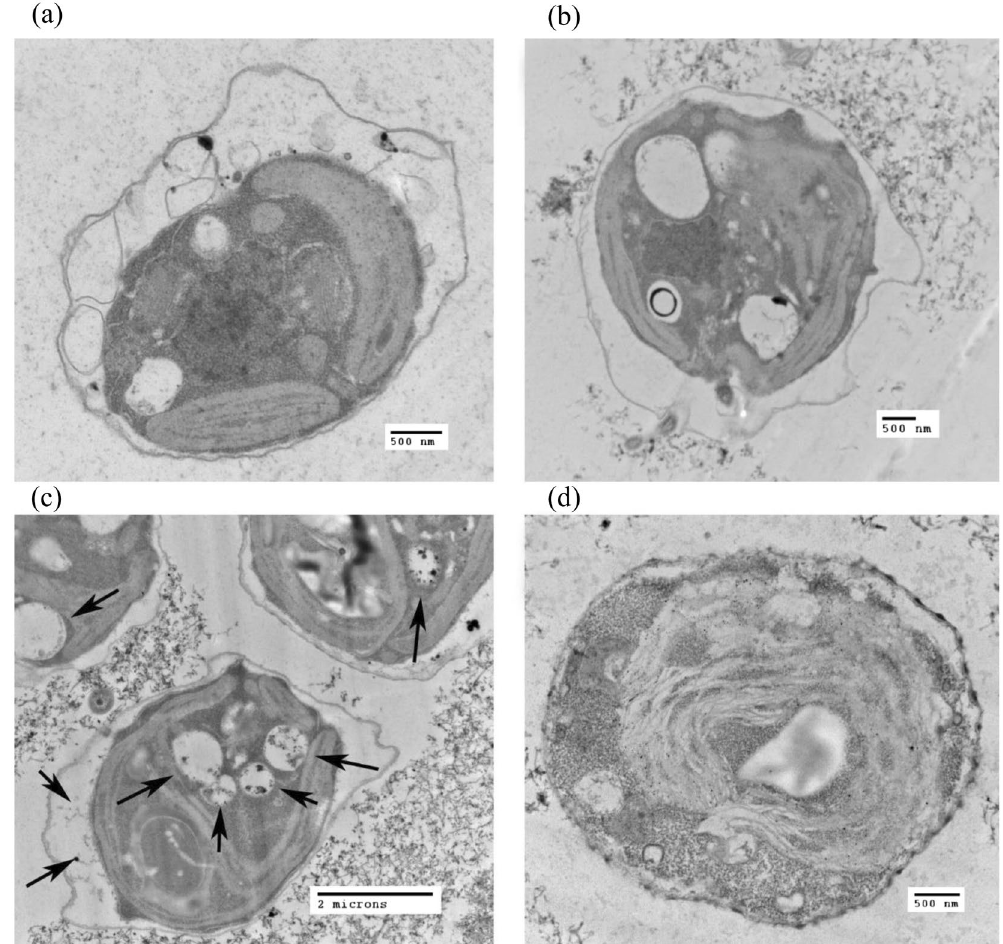
Figure 7. Representative TEM images of algae interactions with CNT variants 24 hours post-exposure. ( a ) Control culture with algae alone. ( b ) Algae cultured with 25 µ g/mL CNT-COOH. ( c ) Algae cultured with 25 µ g/mL CNT-Ag. ( d ) Algae cultured with 25 µ g/mL CNT-Pt. Black arrows indicate particle internalization featuring extensive vacuole formation in